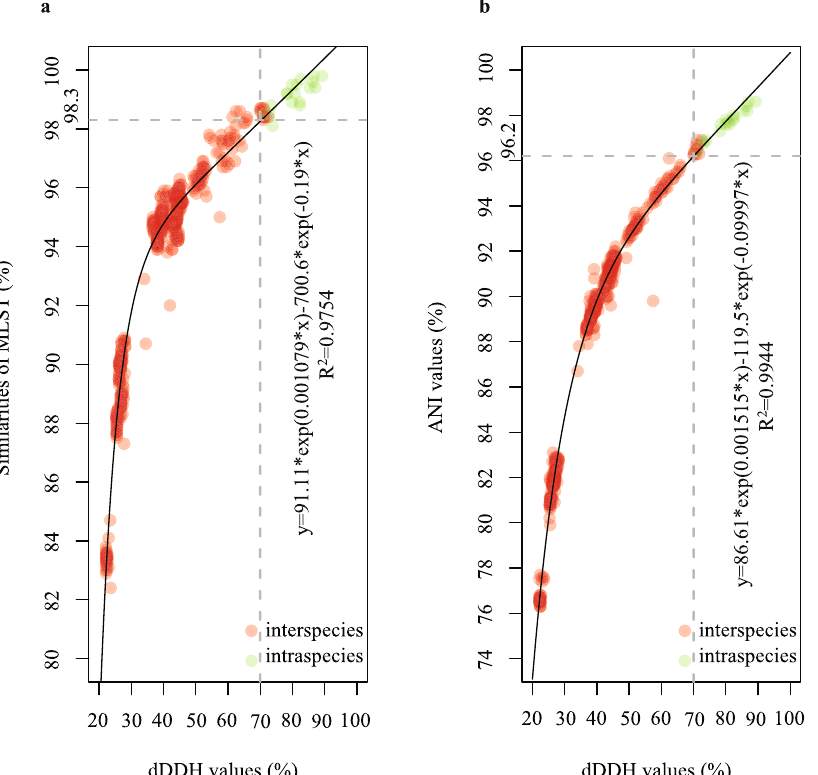
Figure 3. Correlation analyses between the dDDH values and MLST similarities, dDDH and ANI values for 32 strains within this group. The vertical line indicates a 70% dDDH threshold. ( a ) The horizontal line (y = 98.3) indicates the estimated MLST similarity threshold (inter-species) corresponding to 70% dDDH threshold, as given in the key at left. ( b ) The horizontal line (y = 96.2) indicates the estimated ANI threshold (inter-species) corresponding to 70% dDDH threshold, as given in the key at